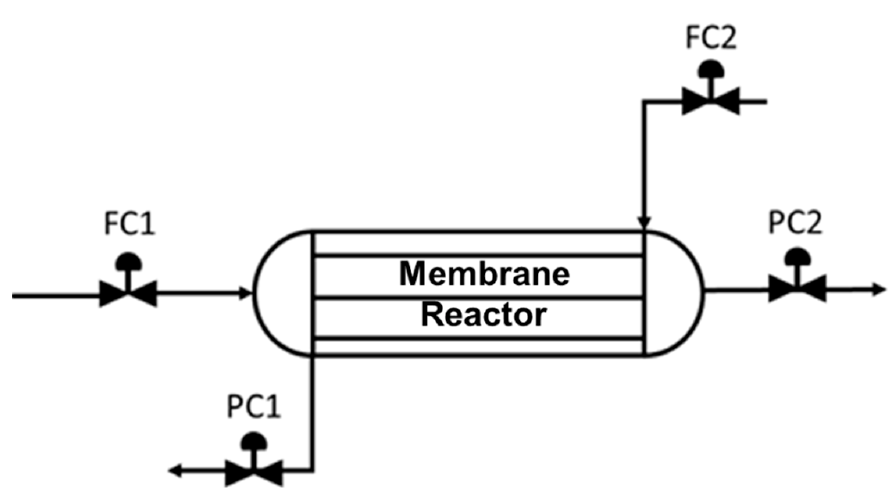
Figure 5. Image of the countercurrent WGS-MR setup where the syngas process flow control valve (FC1) and the sweep gas control valve (FC2) manual positions are changed to generate the AIS.